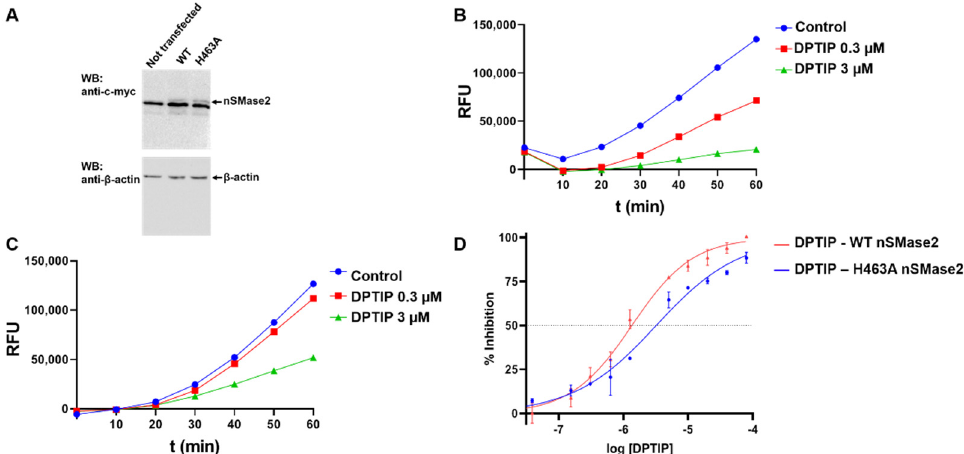
Figure 8. Inhibition of WT and H463A nSMase2 by DPTIP. ( A ) Expression of recombinant nSMase2. Plasmids encoding WT or H463 mutant were transfected into 293T cells and the expression of recombinant nSMase2 variants was determined by western blot using an anti-c-myc antibody 48 h post-transfection. Not transfected cell lysate were included as a negative control. β -actin was detected as a control for protein loading. ( B , C ) Fluorescence intensity curves at two DPTIP concentrations for WT nSMase2 ( B ) and for H463A nSMase2 (n = 3). RFU denotes random fluorescence units. ( D ) IC 50 curves of DPTIP with WT and H463A nSMase2 cell lysates (n = 2).